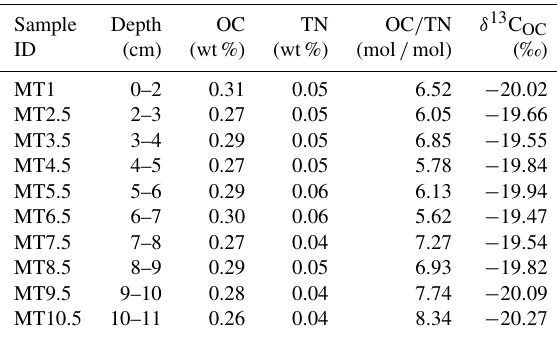
Table 1. Organic carbon (OC) content, total nitrogen (TN) con- tent, molar ratio of OC / TN, and stable carbon isotopic composition ( δ 13 C OC ) in the Mariana Trench